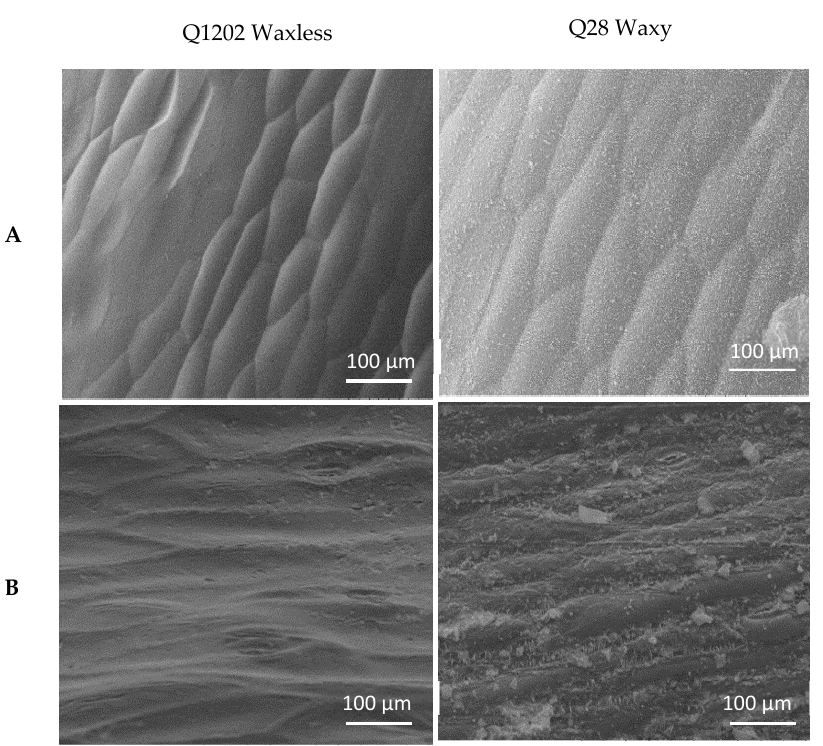
Figure 1. Phenotypes of Q1202 and Q28 at rosette ( A ) and shoot stages( B ) .